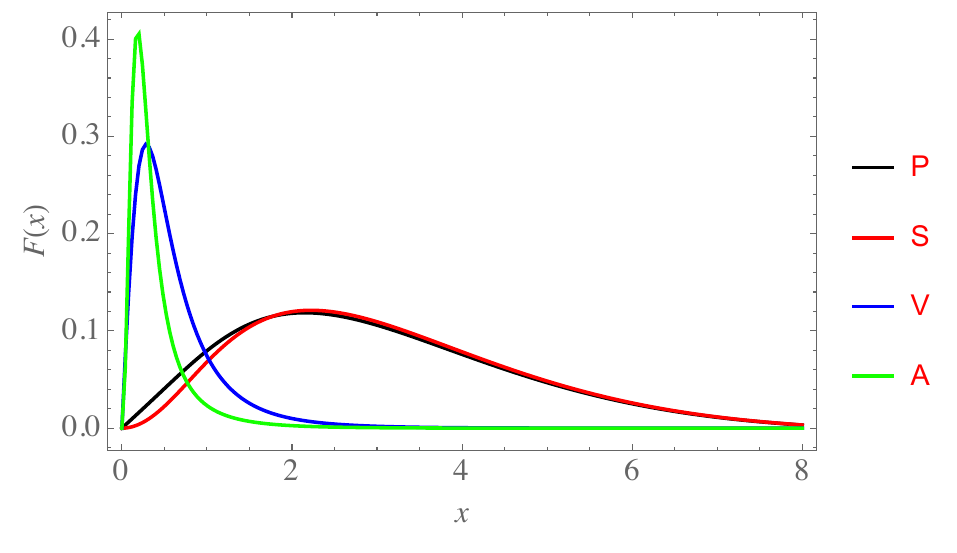
Figure 5 . Form factors for moderate UV cuto(cid:11) at the critical coupling. F ( x ) = p ( p 2 + 1) 1 4 f ( p ) with p = sinh( x ) and m tot =